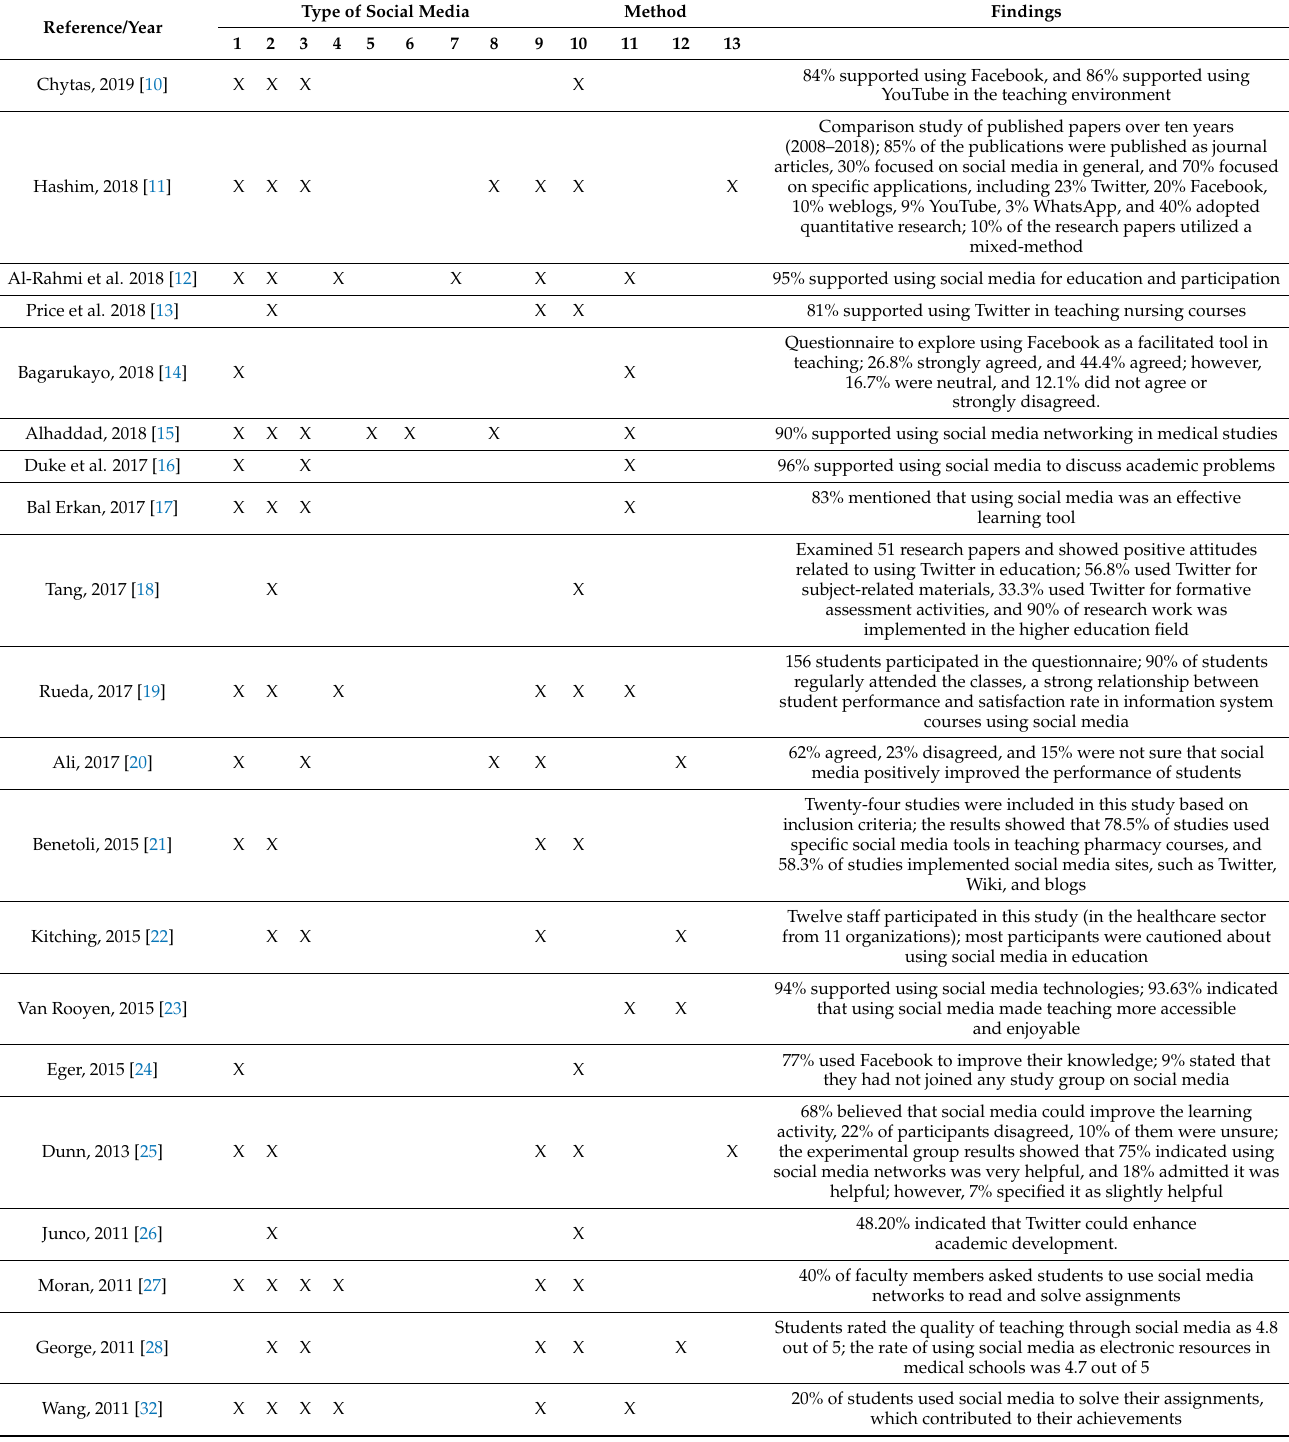
Table 1. Comparative study results. 1, Facebook; 2, Twitter; 3, YouTube; 4, LinkedIn; 5, Instagram; 6, Snapchat; 7, Research gate; 8, WhatsApp; 9, SM-Others; 10, Comparison study and Survey; 11, Questionnaire; 12, Interview; 13,